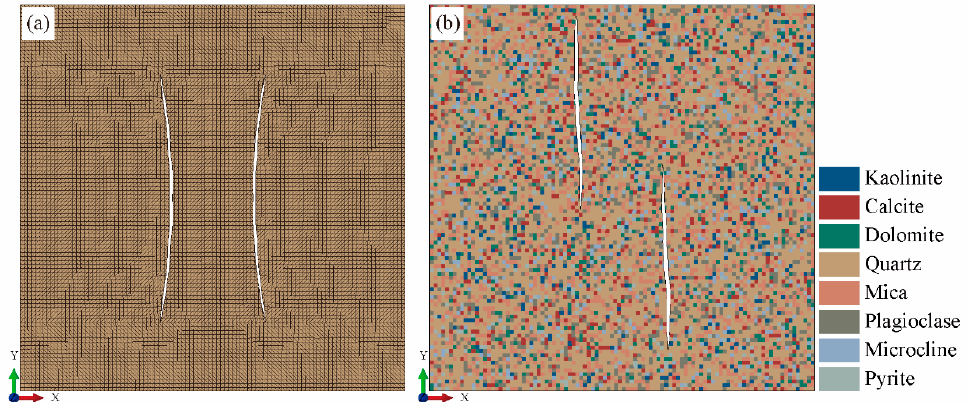
Figure 13. Comparison of fracture paths in two media. ( a ) Isotropic model. ( b ) Mineral heterogeneity model.